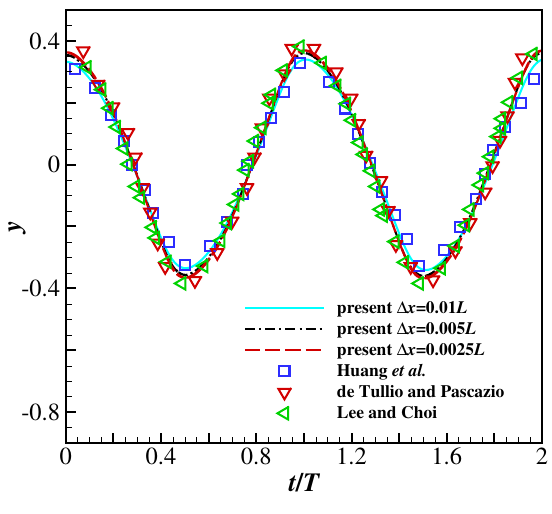
Figure 2. A 2D filament flapping in a Newtonian uniform flow: the time history of the transverse displacement of the trailing edge node.